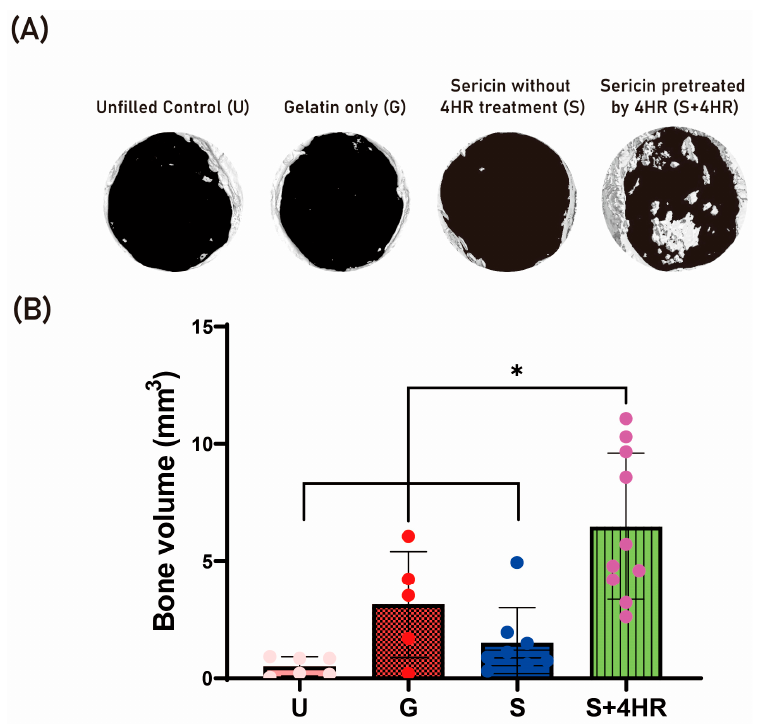
high temperature with (S+4HR group) and without (S group) 4HR pretreatment resulted in mean ± SD BVs of 6.47 ± 3.13 mm 3 and 1.50 ± 1.48 mm 3 , respectively. The mean BV was significantly higher in the S+4HR group than in the S ( p < 0.001), U ( p < 0.001), and G ( p = 0.028) groups.